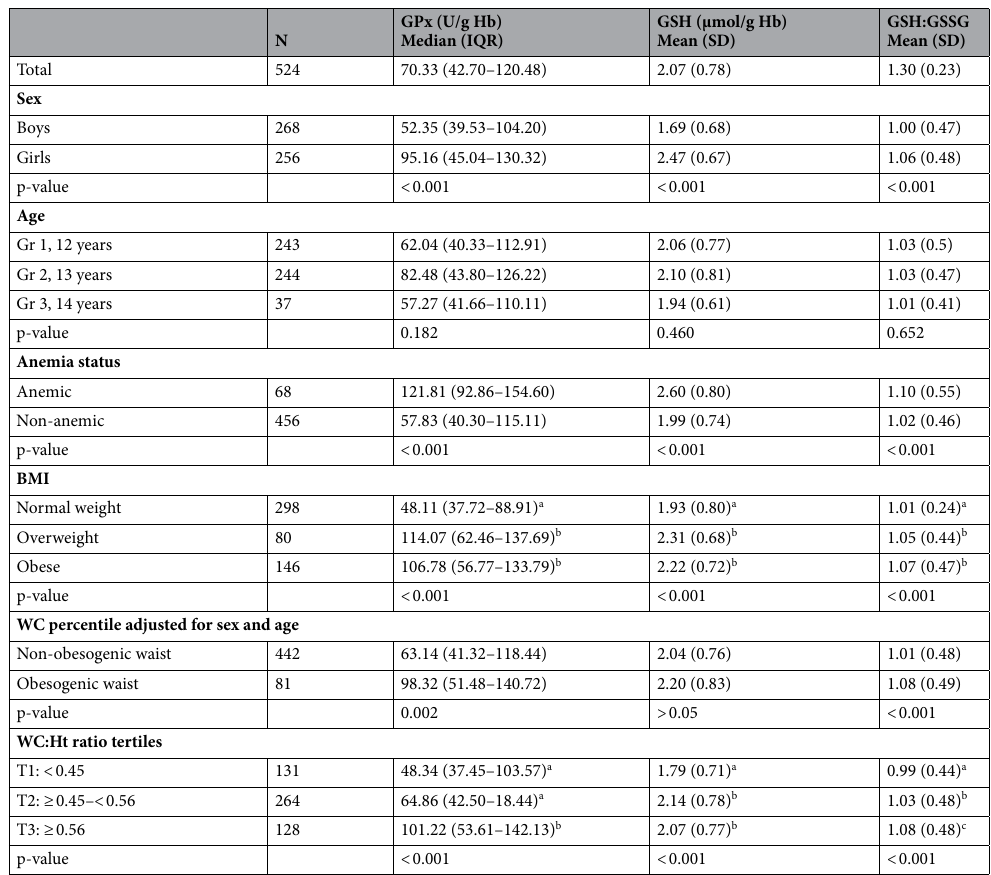
Table 4. Levels of GPx, GSH, and GSH:GSSG. In the categories of sex, anemia status, and WC percentile, the GPx data were analyzed using the chi-square test, and the GSH and GSH:GSSG data were analyzed using the independent-samples t-test. In the categories of age, BMI, and WC:Ht tertiles, GPx data were analyzed using the independent-samples median test, whereas the GSH and GSH:GSSG ratio data were analyzed using one- way ANOVA. p-values are for two-tailed tests. The GSH:GSSG ratio was transformed into square root, and mean (SD) values were converted back into the original form by squaring them. Superscript letters denoting values in the same column in the same category indicate significant differences. GPx glutathione peroxidase, Hb hemoglobin, IQR interquartile range, GSH reduced glutathione, SD standard deviation, GSSG glutathione disulfide, BMI body mass index, WC waist circumference, Ht